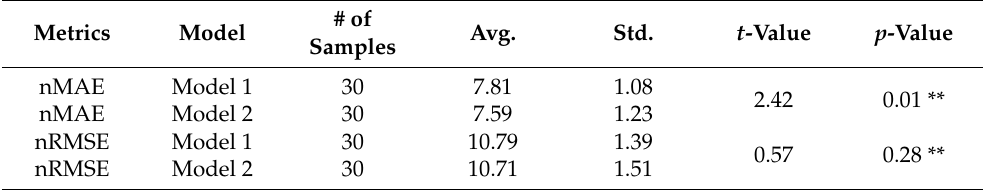
Table 8. Paired t -test